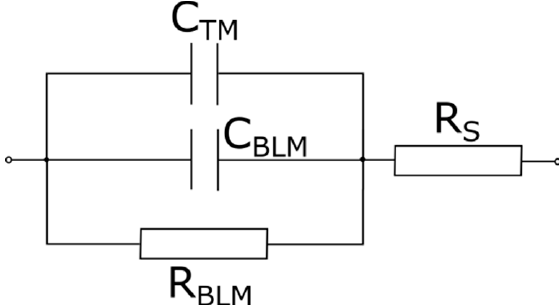
Figure 1. Equivalent circuit model of Montal–Mueller cell for formation of bilayer lipid membranes (BLMs): C BLM —BLM capacitance; R BLM —BLM resistance; C TM —capacitance of the Teflon mem- brane; R s —resistance of the aqueous solution.